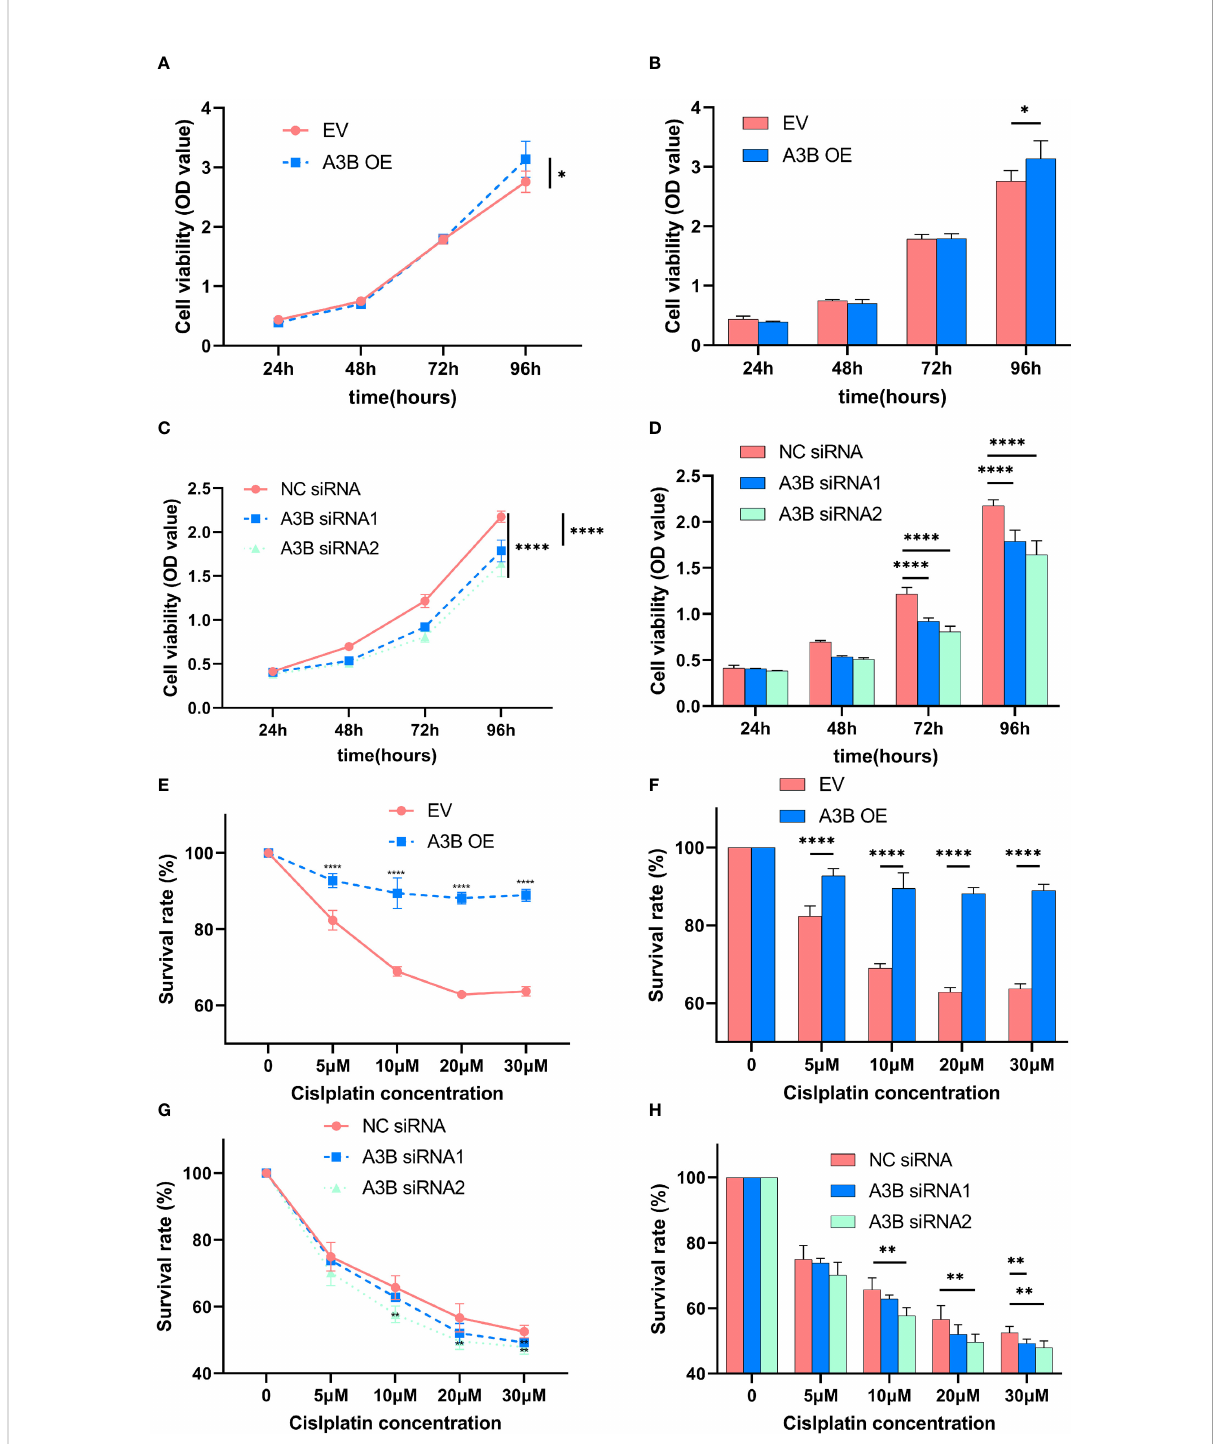
FIGURE 8 Effects of A3B on the proliferation and chemoresistance of cervical cancer. (A, C) A3B promotes SiHa and HeLa cell proliferation in vitro . (B, D) Statistical analysis of (A, C) . (E, G) A3B expression promotes cisplatin resistance in SiHa and HeLa cell in vitro . (F, H) Statistical analysis of (E, G) . * p < 0.05; ** p < 0.01; **** p <